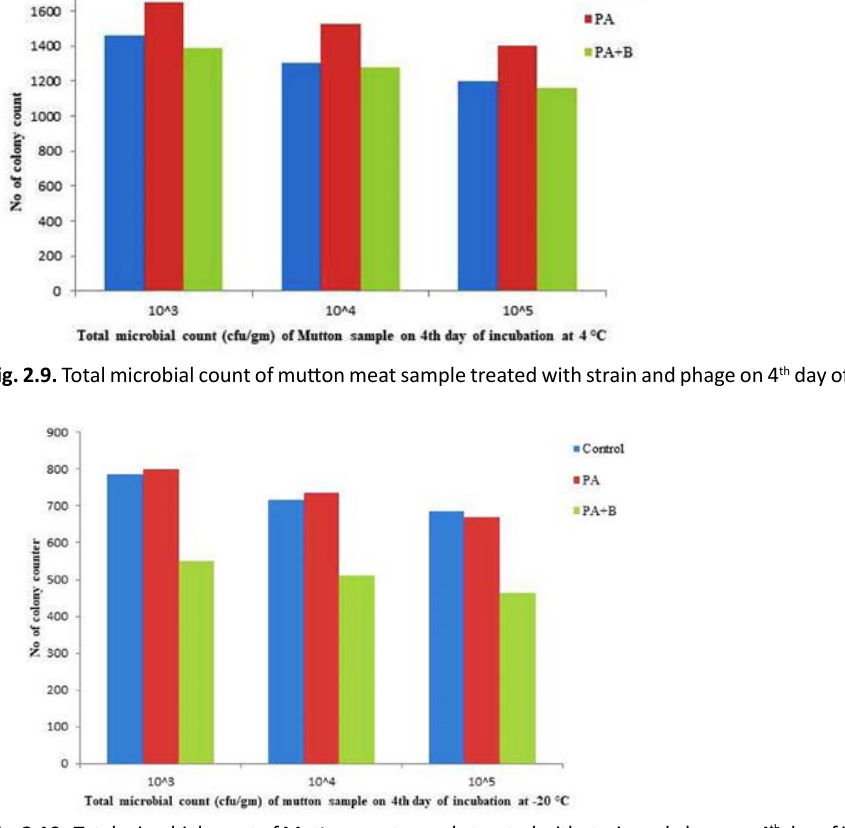
Fig. 2.10. .Total microbial count of Mutton meat sample treated with strain and phage on 4 th day of incubation at -20